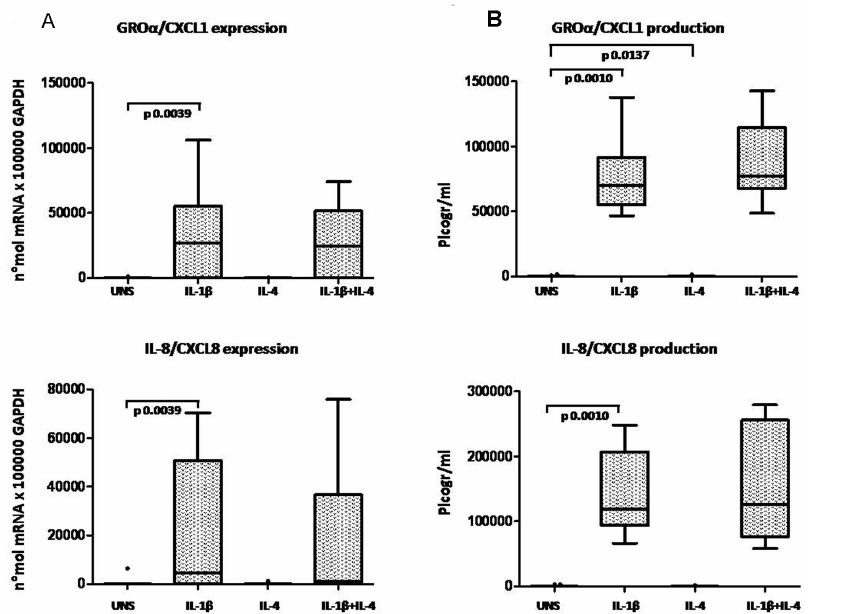
Figure 5. Evaluation of IL-4 anti-inflammatory activity on CXC chemokine expression in high-density OA chondrocytes. A : mRNA expression; B : protein production. Chemokines were detected in chondrocytes (cells and culture supernatants) after 24 hours of incubation in unstimulated condition (UNS) and in the presence of IL-1 b (2 ng/ml), IL-4 (10 ng/ml), or a combination of the two cytokines. Boxes indicate the 25% and 75% percentiles, whiskers indicate the minimum to maximum values, bars indicate the median; solid circles indicate outliers. After Bonferroni’s correction, p values below 0.0165 were considered significant.